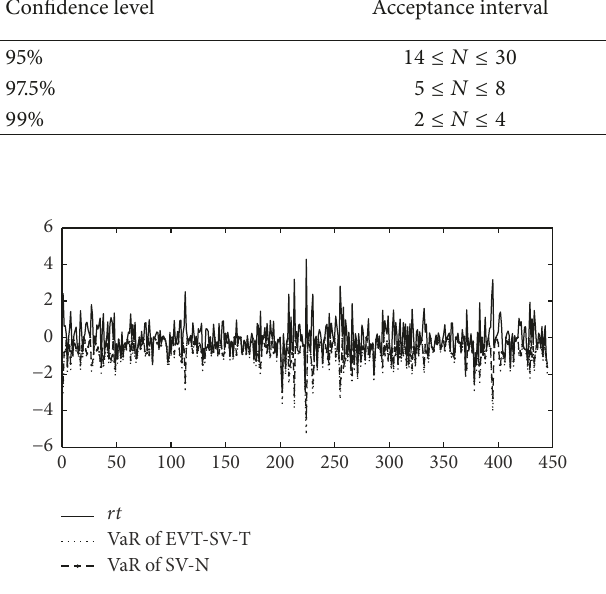
Figure 6: The VaR of the yield under the assumption of different distribution under the 95% confidence level.